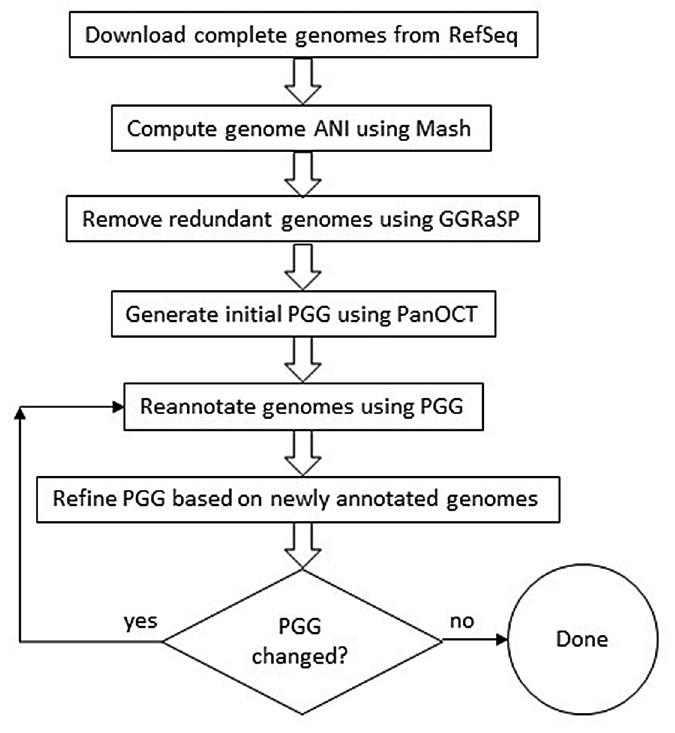
Figure 1. High-level overview of our method for generating a refined PGG.